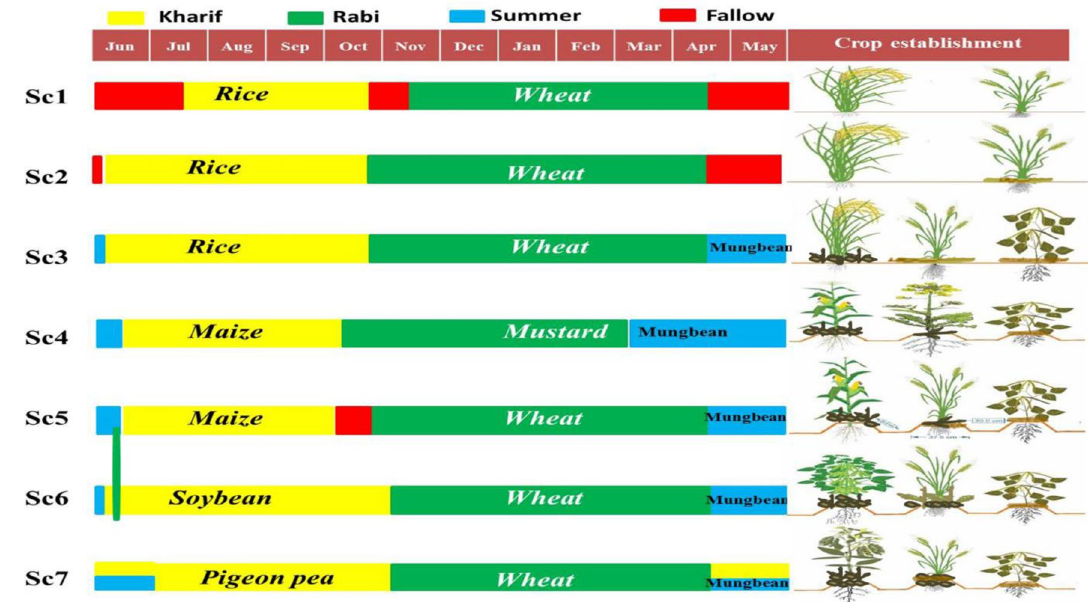
Figure 5. Schematic diagram of different crops and cropping sequence under different crop establishment methods .